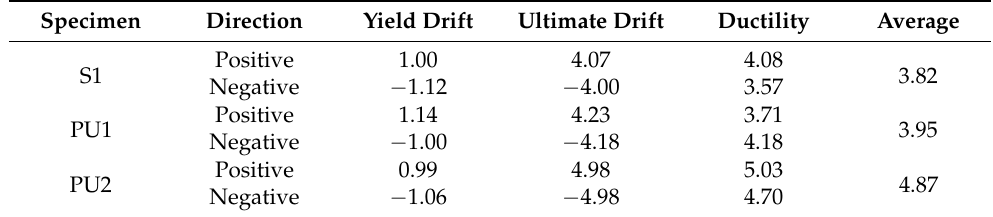
Table 5. Comparison of the ductility of